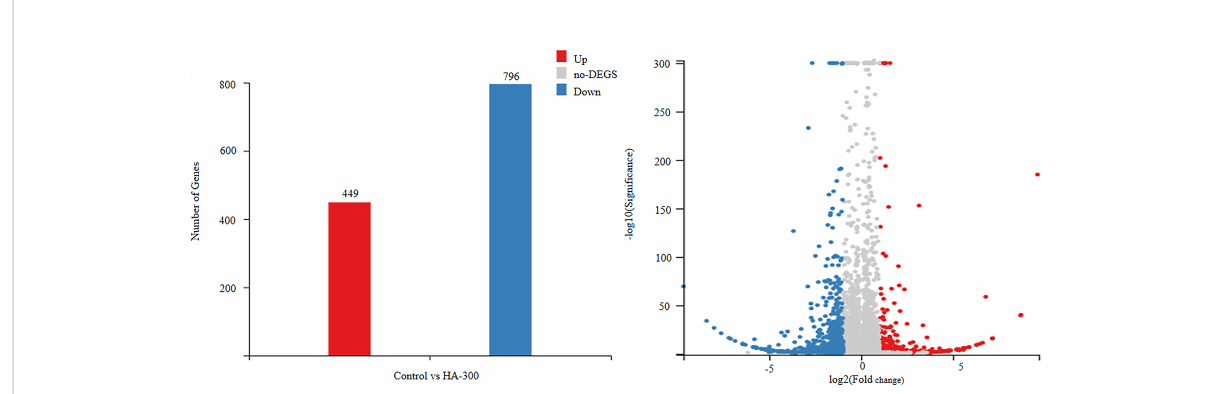
FIGURE 2 Differentially expressed genes (DEGs) |log 2 (fold change)| ≥ 1, q -value ≤ 0.05] in the liver transcriptome of largemouth bass fed diets with 0 and 300 mg kg -1 b -glucan. The blue dots and column represent signi fi cantly downregulated DEGs, and the red blue dots and column represent signi fi cantly upregulated DEGs, the gray signi fi es no DEGs.